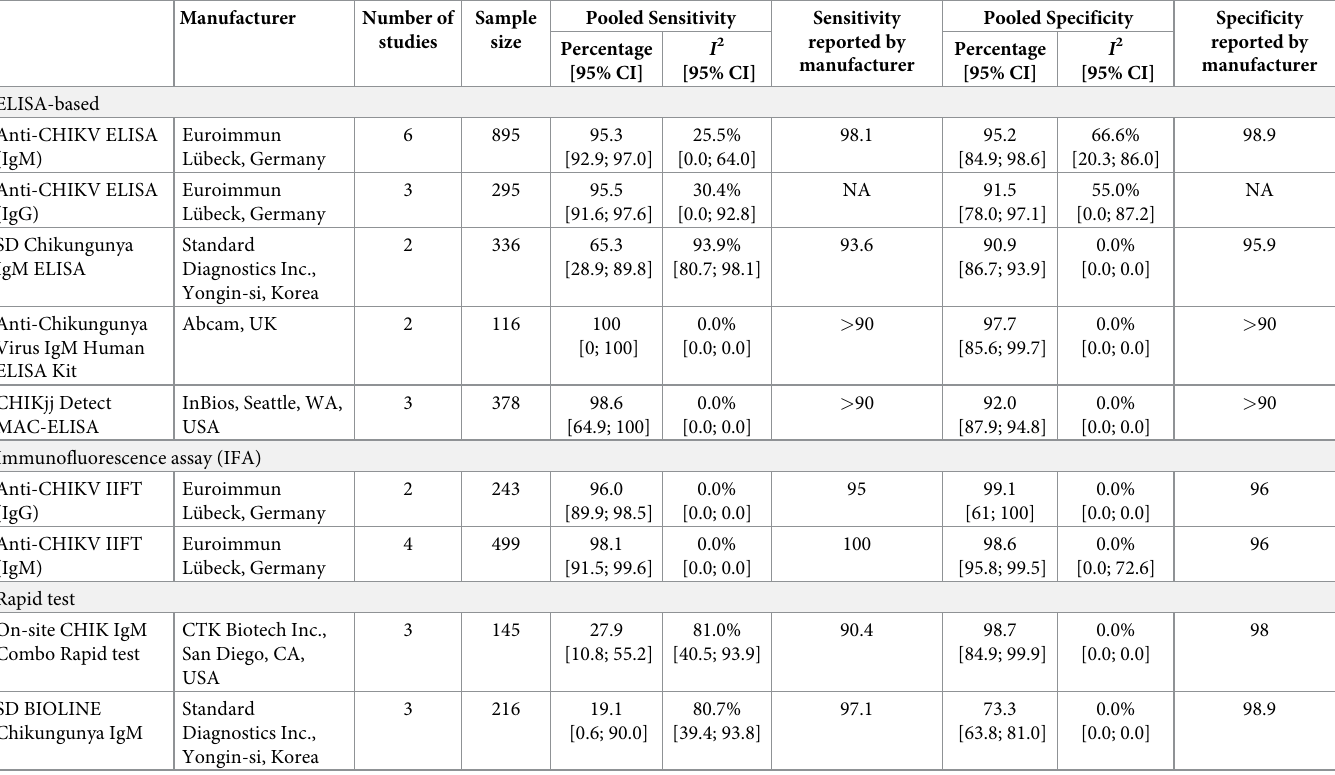
Table 9. Subgroup analysis for commercial tests.